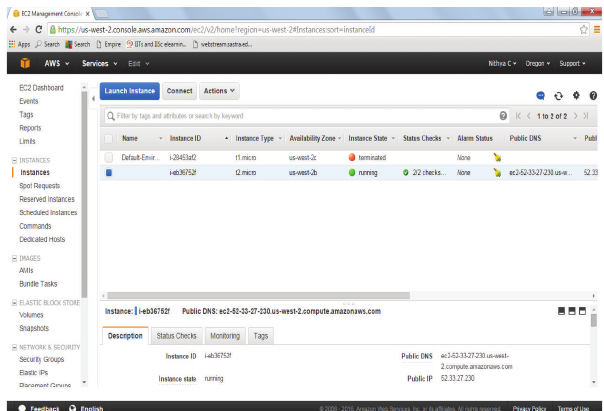
Figure 2: EC2 dashboard in Amazon Web Services